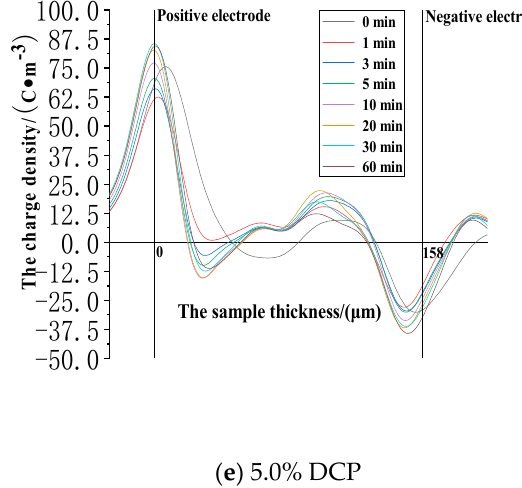
Figure 6. The space charge distribution when voltage is applied to each sample at the electric field strength of 80 kV/mm. ( a ) The experimental results of the pure LDPE samples. ( b ) The experimental results of the samples with 1.0% DCP. ( c ) The experimental results of the samples with 2.1% DCP. ( d ) The experimental results of the samples with 3.0% DCP. ( e ) The experimental results of the samples with 5.0% DCP.